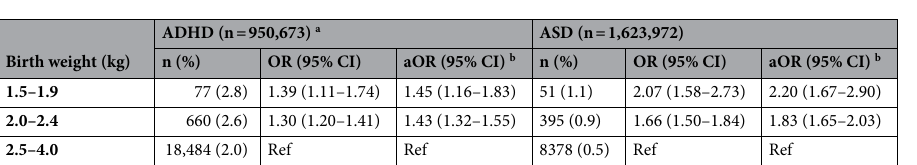
Table 3. Associations of birth weight with ADHD and ASD in children with no history of congenital or perinatal diseases. ADHD attention-deficit/hyperactivity disorder, ASD autism spectrum disorder, OR odds ratio, aOR adjusted odds ratio, CI confidence interval. a The analysis of ADHD included children born between 2008 and 2010, and the analysis of ASD included children born between 2008 and 2012. b Adjusted for sex, income and birth year.